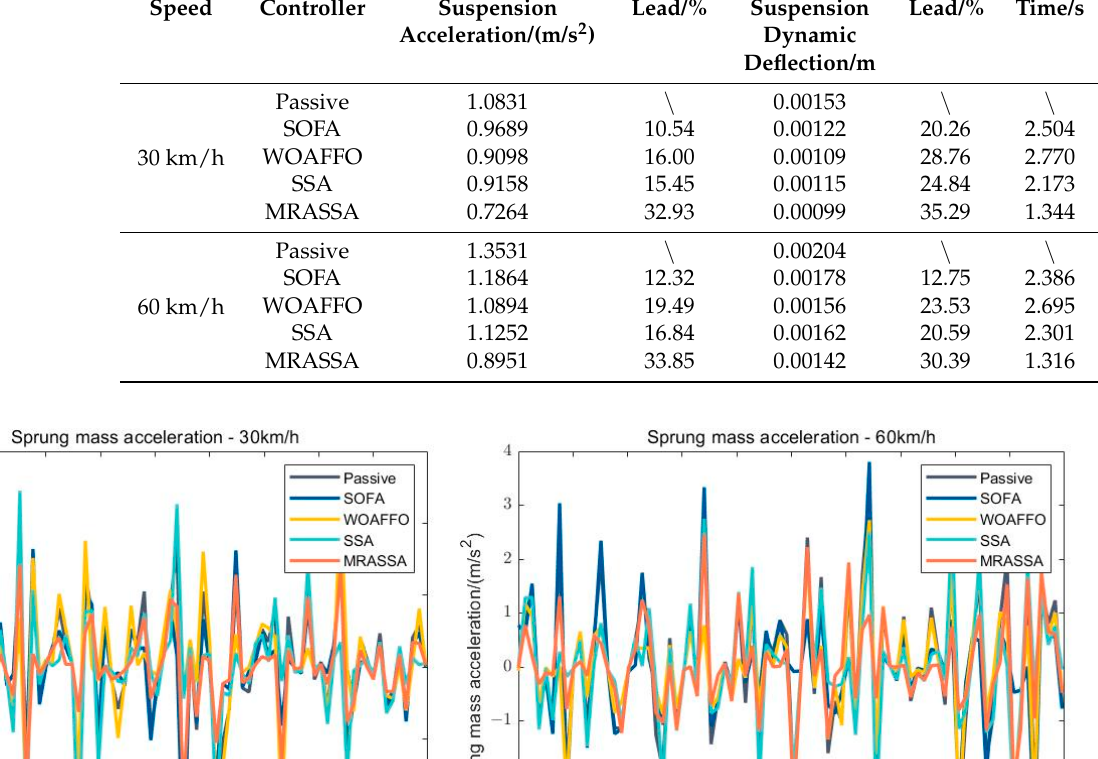
Table 6. Optimization Results for Platform of the Random Road.